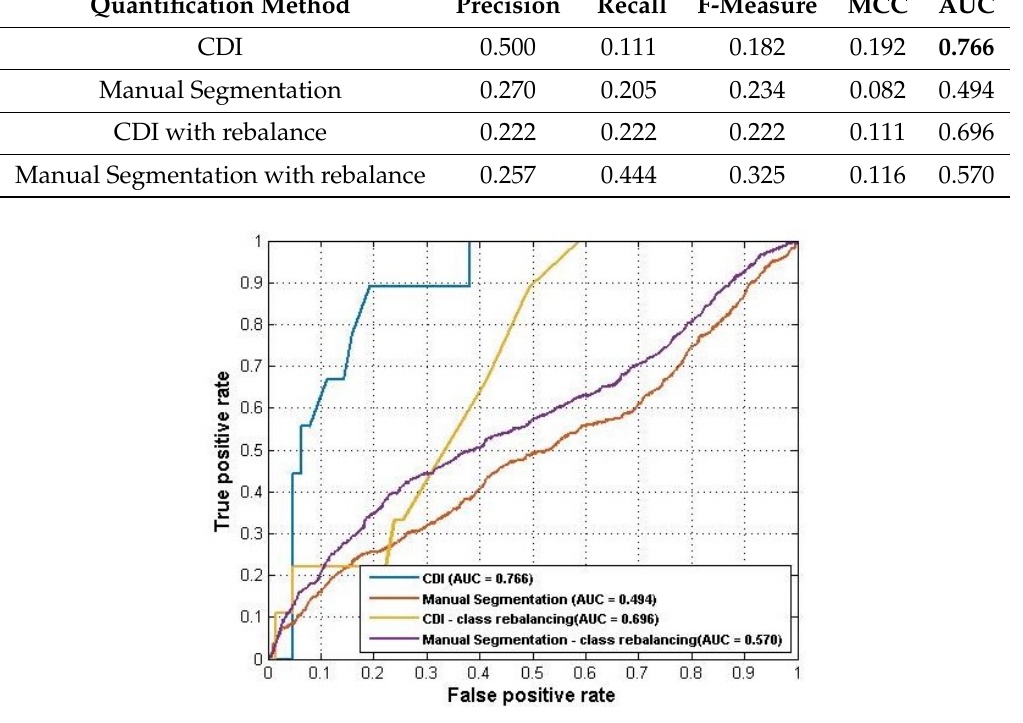
Figure 4. ROC plot of middle CDI (#4, #5, and #6) and manual segmentation on X2 slice.